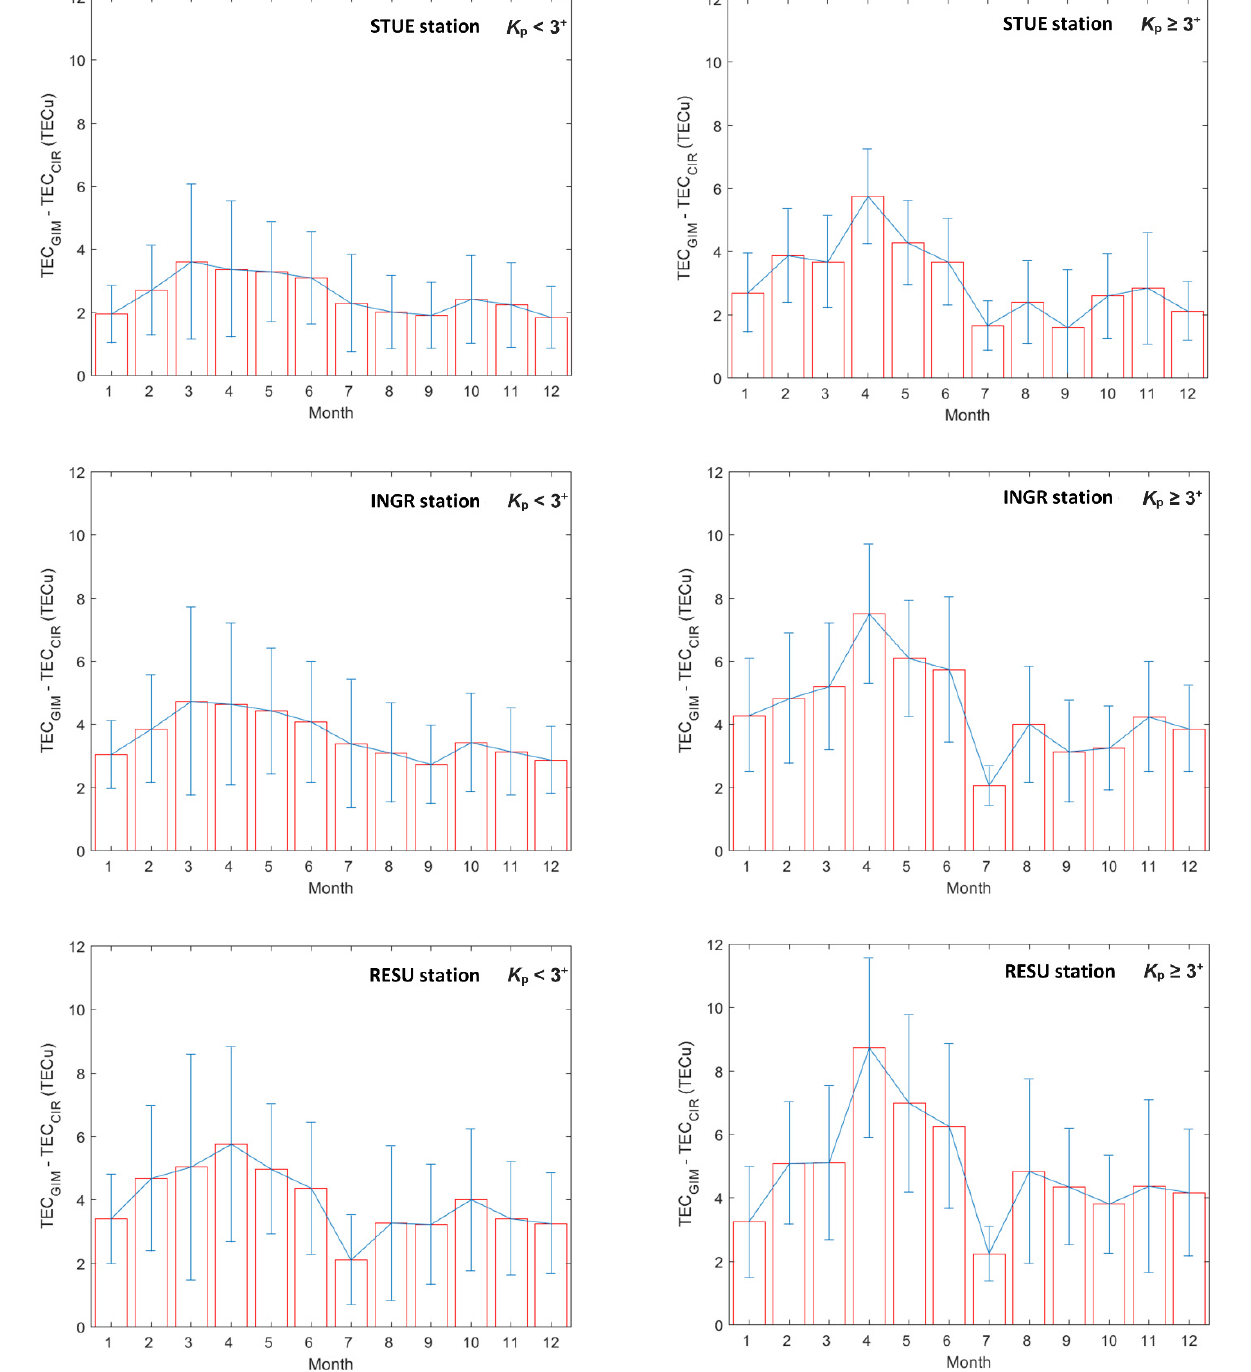
Figure 4. Mean monthly variation of the difference (TEC GIM - TEC CIR ), and corresponding standard deviation, for STUE (upper row), INGR (middle row) and RESU (lower row). Left panels refer to quiet geomagnetic values ( K p < 3 + ), while right panels refer to disturbed geomagnetic values ( K p ≥ 3 + ). For this analysis the LSA period (July 2008–June 2009) was joined to the HSA period (September 2013–August 2014).